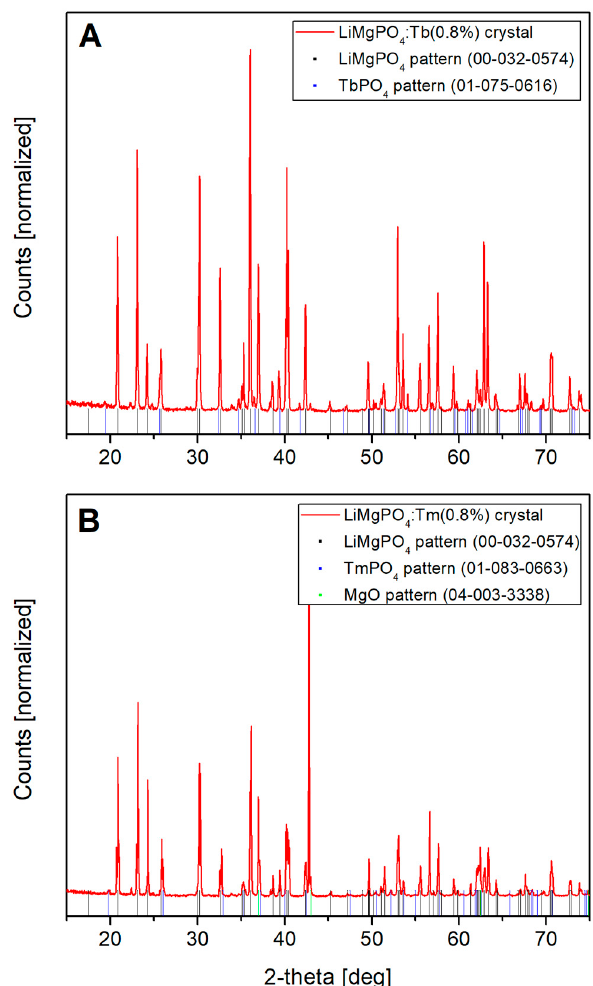
Figure 4. The XRD phase analysis performed for LMP:Tb (0.8 mol%, A ) and LMP:Tm (0.8 mol%, B ) crystals. Small amounts of TbPO 4 and TmPO 4 phases were found, respectively.